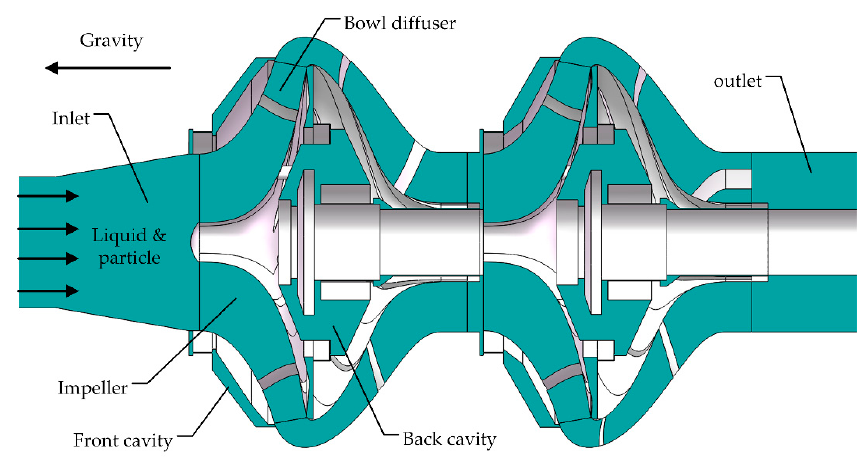
Figure 2. The two-stage hydraulic model.